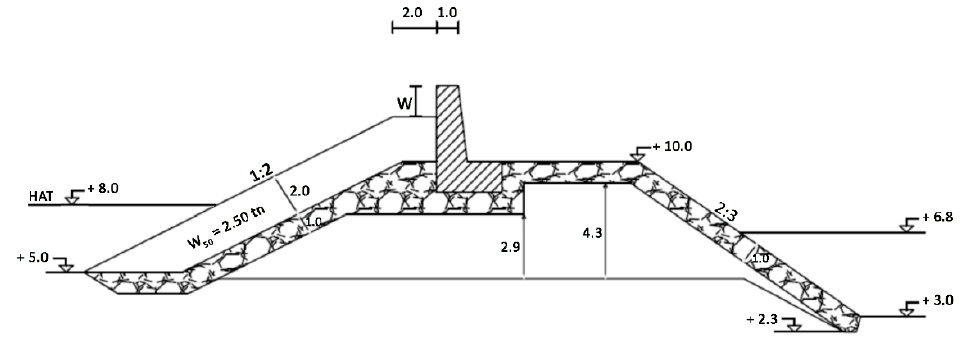
Figure 6. Cross-section of the studied rubble mound breakwater in Deauville, France, for mitigation option 1.